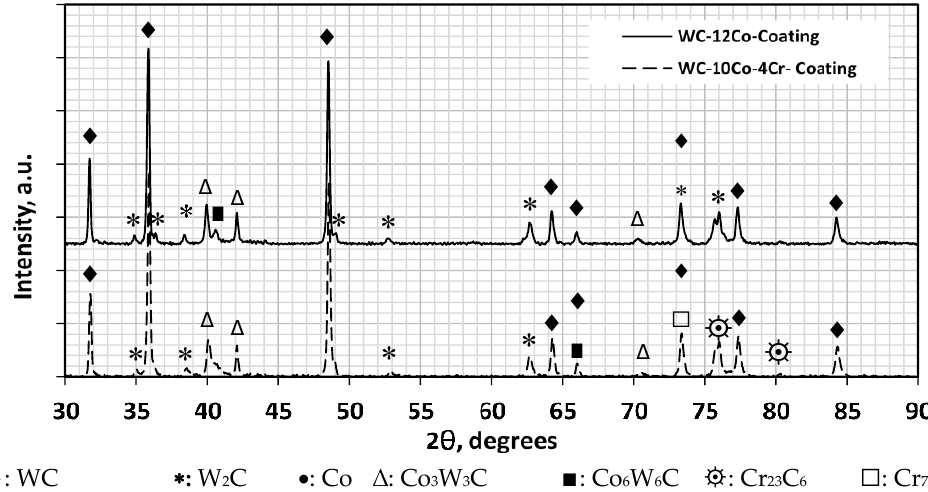
Figure 14. XRD-patterns comparing WC-12Co and WC-10Co-4Cr in coating condition.